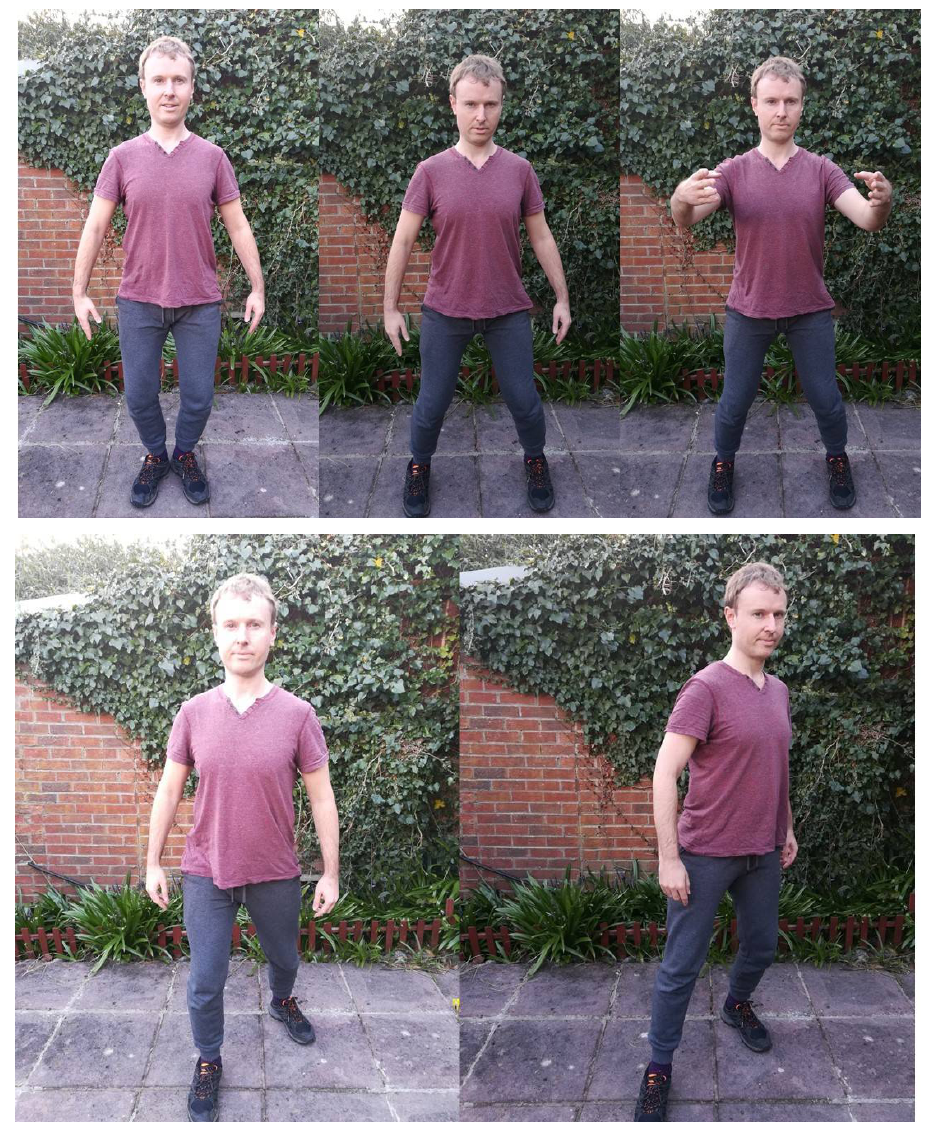
Figure 4. Three Training Stances of Opening Stance, Neutral Stance and Zhan Zhuang plus Ba Men forwards and backwards.